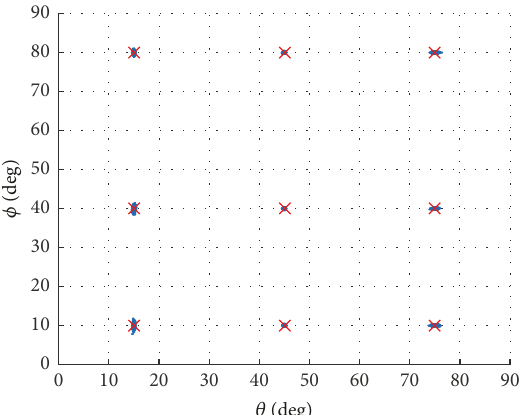
Figure 7: 2D DOA estimation results of 9 incident signals, SNR = 5